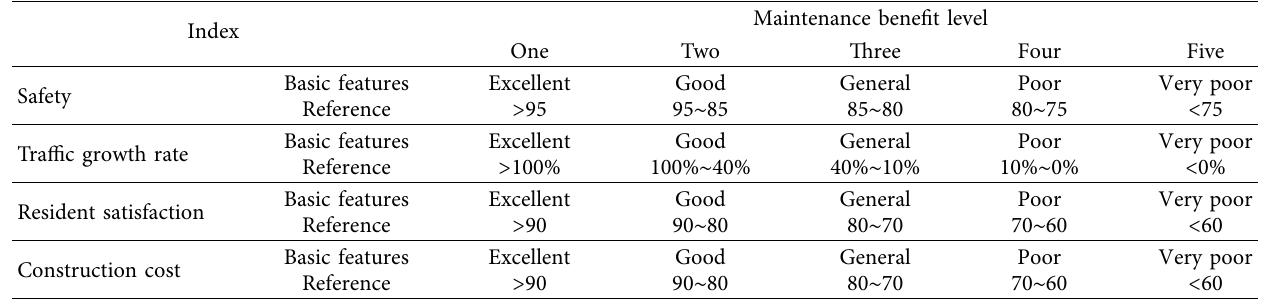
Table 3: Reference value of index system classifcation standard.